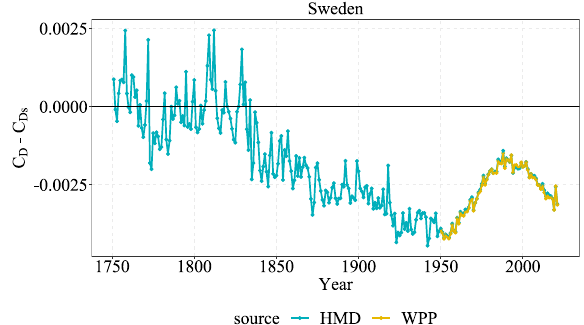
Fig. 3 The sensitivity of crude death rate ( C D — C Ds ) in Sweden from HMD and WPP,